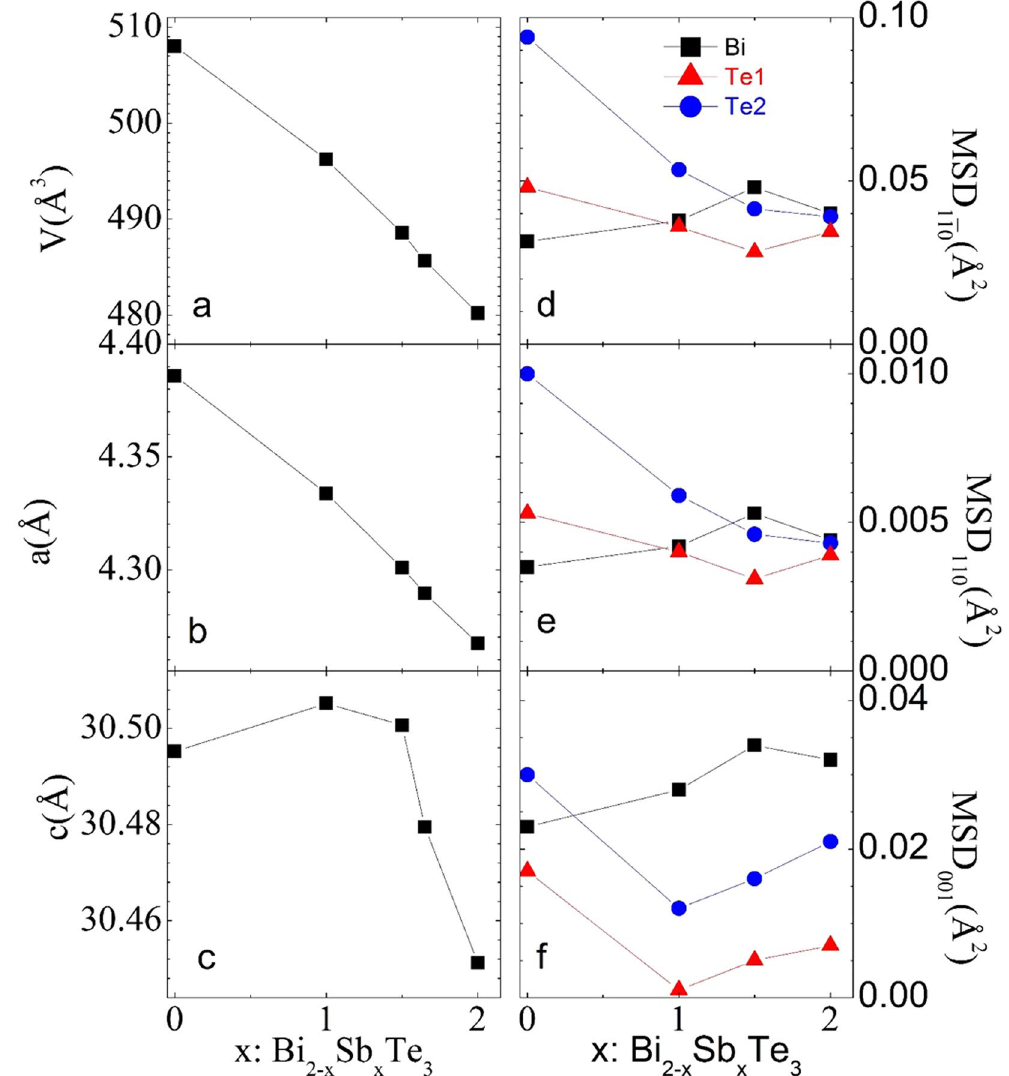
Figure 3. Composition dependence of the unit-cell volume ( a ) and lattice parameters ( b , c ) and of the MSDs ([11–0], [110, [001] in d,e,f ), respectively, at room temperature. Black squares for Bi, Red triangles for Te1 and Blue circles for Te2. MSD data for x = 1.65 are not included as they were collected in a different